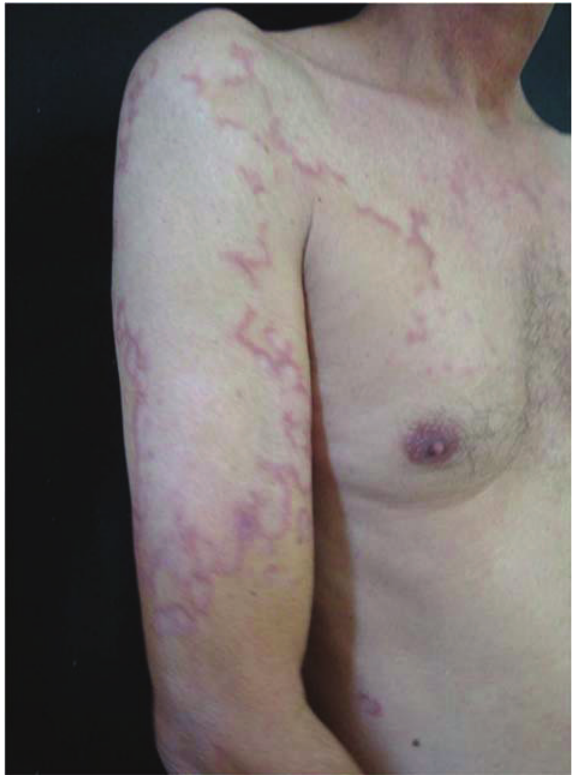
Figure 2: Detail of the erythematous annular lesion.